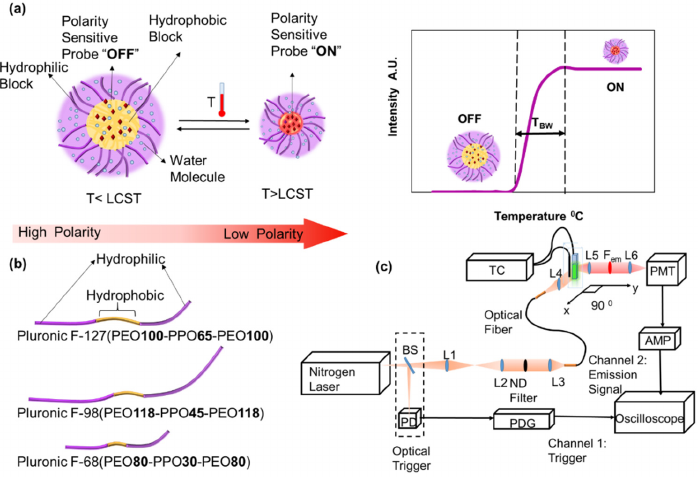
Figure 1. ( a ) Nanoparticles made of thermoresponsive Pluronic block copolymers, embedded with polarity-sensitive fluorophores, respond to the increase in temperature. By shrinking and excreting the water from the core of the nanoparticles, polarity is significantly decreased and polarity-sensitive fluorophores switch to “ON.” ( b ) Pluronic F-127, F-98, and F-68 triblock copolymers with hydrophobic and hydrophilic chains [12,13]. ( c ) A schematic of the optical measurement